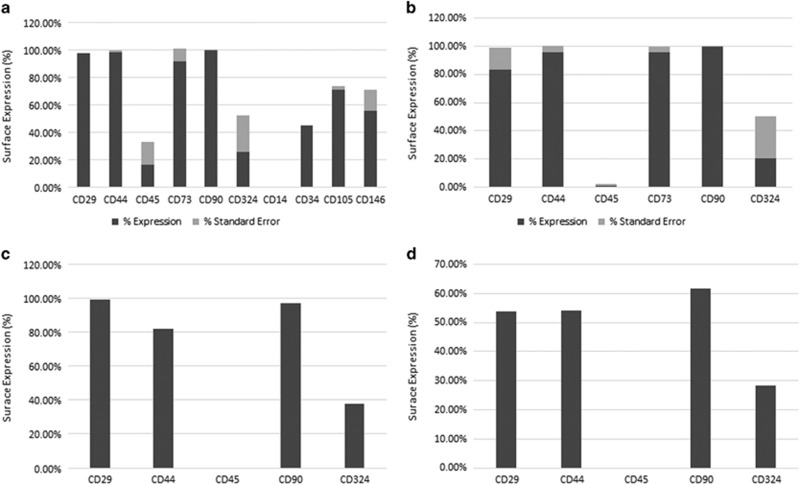
Characterization of the immunophenotype of AML BM-MSCs, normal BM-MSCs and stromal cell lines by flow cytometry reveals similar surface marker expression. (a) Surface marker expression of AML BM-MSCs (n=3). (b) Surface marker expression of BM-MSCs from healthy donors (n=3). (c) Surface marker expression of stromal cell line HS-5 (n=1). (d) Surface marker expression of stromal cell line HS-27a (n=1).